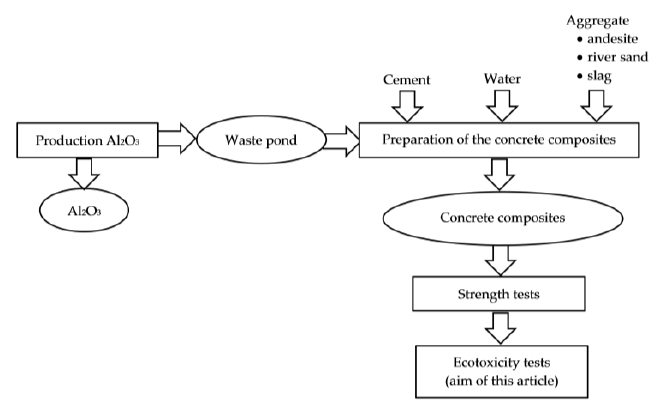
Figure 1. Waste flow and concrete composite preparation. Table 1. Formulations (percent by mass) of the preparation of concrete composites with the application of granulated slag from the pilot production of gray iron.